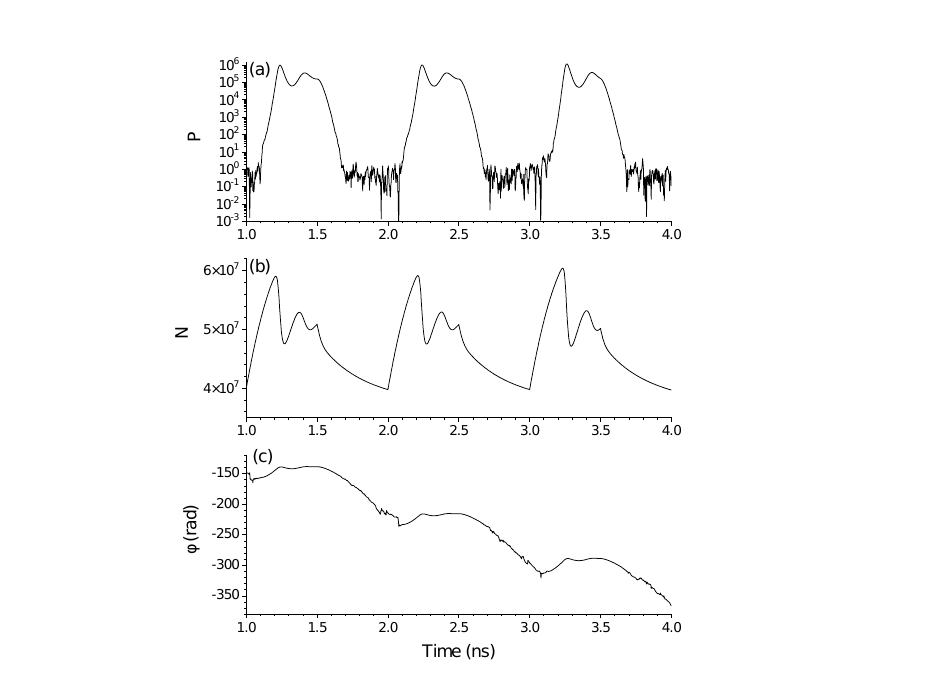
Figure 1. ( a ) Photon number, ( b ) carrier number, and ( c ) optical phase as a function of time for three consecutive pulses when T = 1